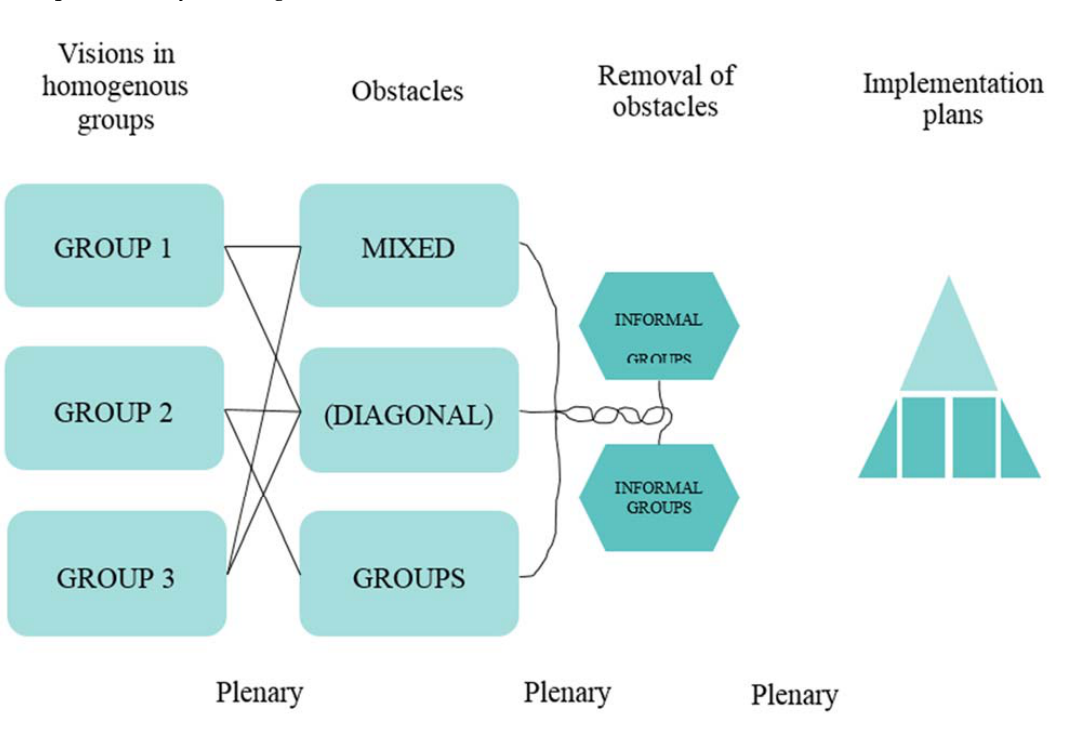
Figure 1. The progression of the dialogue (work) conferences.